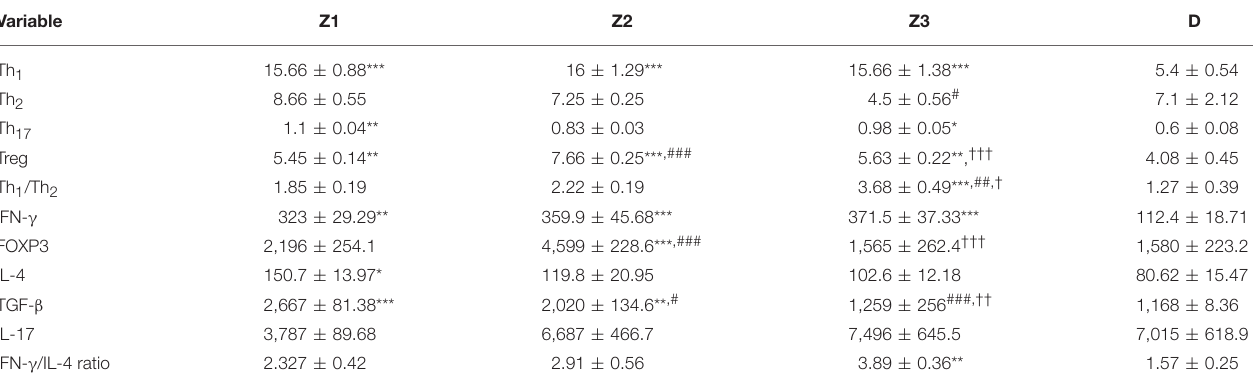
TABLE 2 | The percent of T cells and values of IFN- γ , IL-4, TGF- β , FOXP3, and IL-17 gene expressions as well as IFN- γ /IL-4 ratio of splenocyte in asthmatic groups treated with the extract of Z. multiflora at concentrations 200, 400, and 800 µ g/ml (groups Z1, Z2, and Z3, respectively) and dexamethasone (D, 0.1 mM).